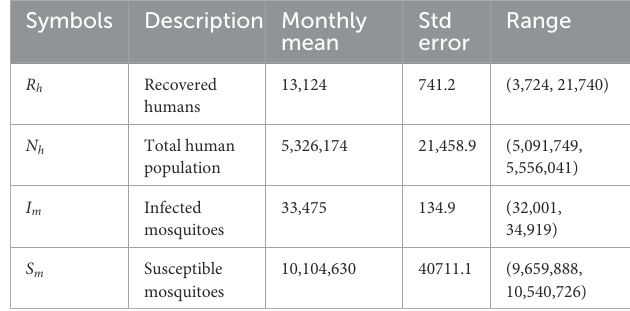
TABLE 2 Predicted variables summary statistic.